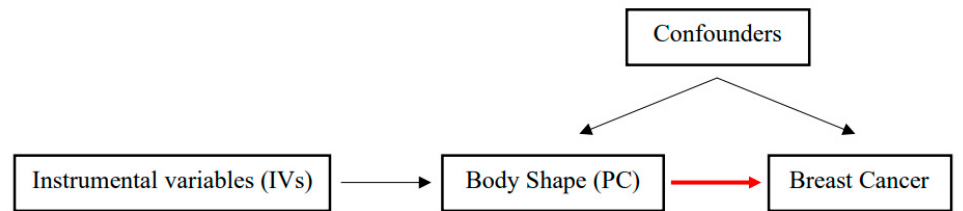
Figure 1. Causal directed acyclic graph (DAG) of Mendelian Randomization analysis. The red arrow highlights the causal association between the body shape (exposure) and breast cancer (outcome) assessed. PC, principal component.